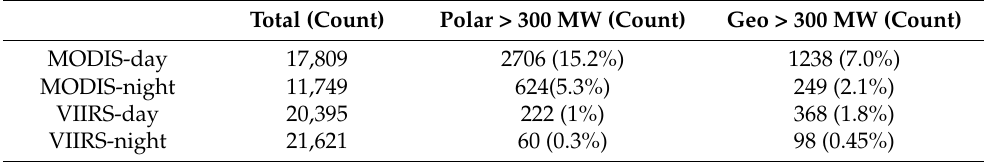
Month-by-month 2D FRP histograms of non-saturated matched hotspots (Figure 3) again demonstrate the dominance of lower power fires on FRP comparisons. Peak counts occurred in similar FRP values for MODIS (and VIIRS) and BRIGHT/AHI (see Figure 3 color bar; log-scale). Strong disagreements in FRP values were less frequent than more similar FRP values. The highest levels of disagreement (i.e., low FRP in one sample and high FRP in the other) occurred in the months affected by the “Black Summer” Fires [22], i.e., during high-radiative-power